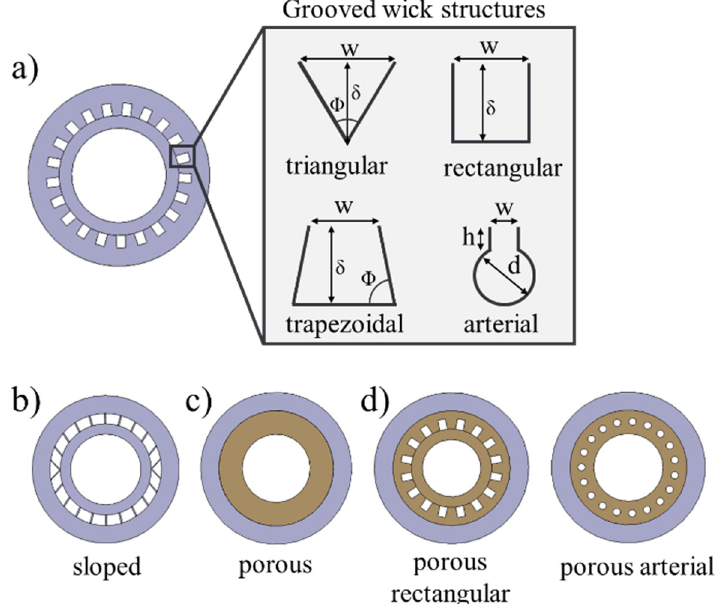
Figure 1. Different wick structures: ( a ) geometrically determined grooved wick structures and char‑ acteristic dimensions, ( b ) sloped grooved wick structure, ( c ) porous wick structure, and ( d ) hybrid wick structures.